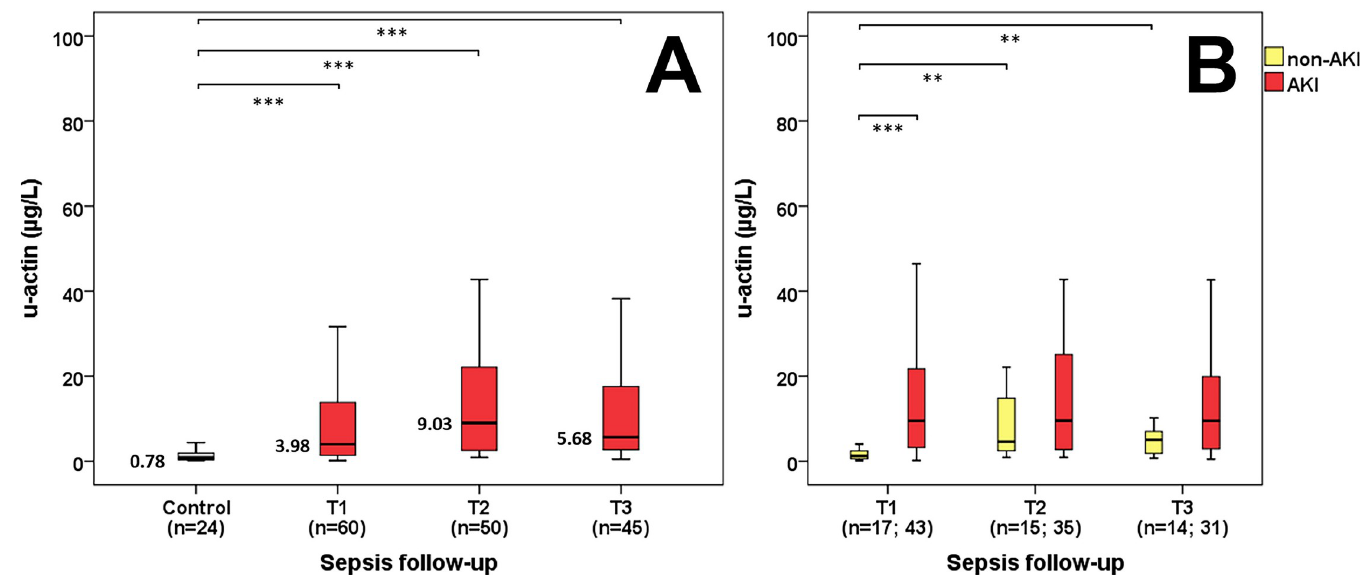
Fig 1. Urinary actin in sepsis. U-actin levels of control and septic patients (A) along with sepsis and sepsis-related AKI patients (B) during follow-up. n: sample count. �� p < 0.01; ��� p < 0.001.